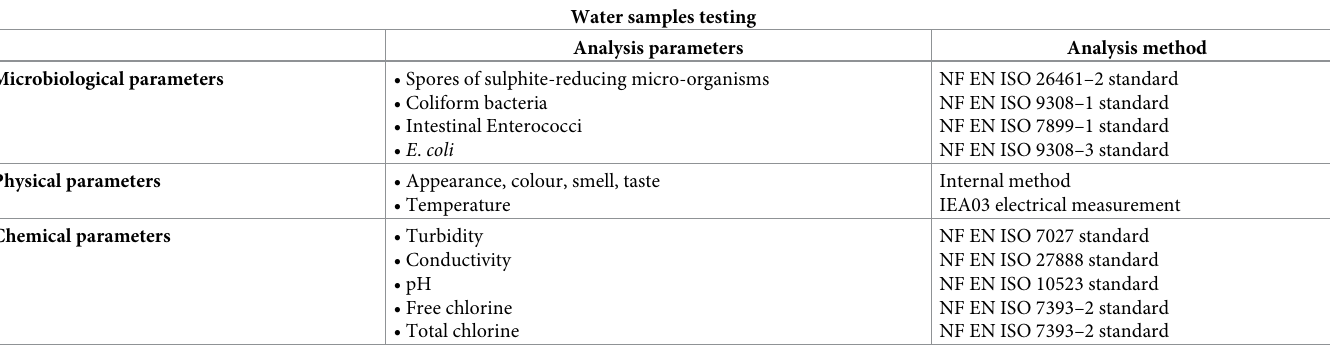
Table 1. Analysis parameters and testing methods applied to water samples, France,